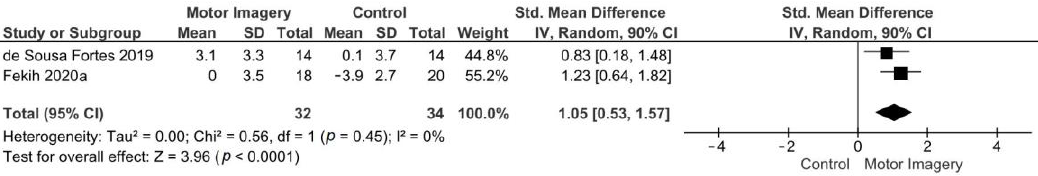
Figure 4. Effect of motor imagery training on tennis service accuracy versus watching videos as control intervention.